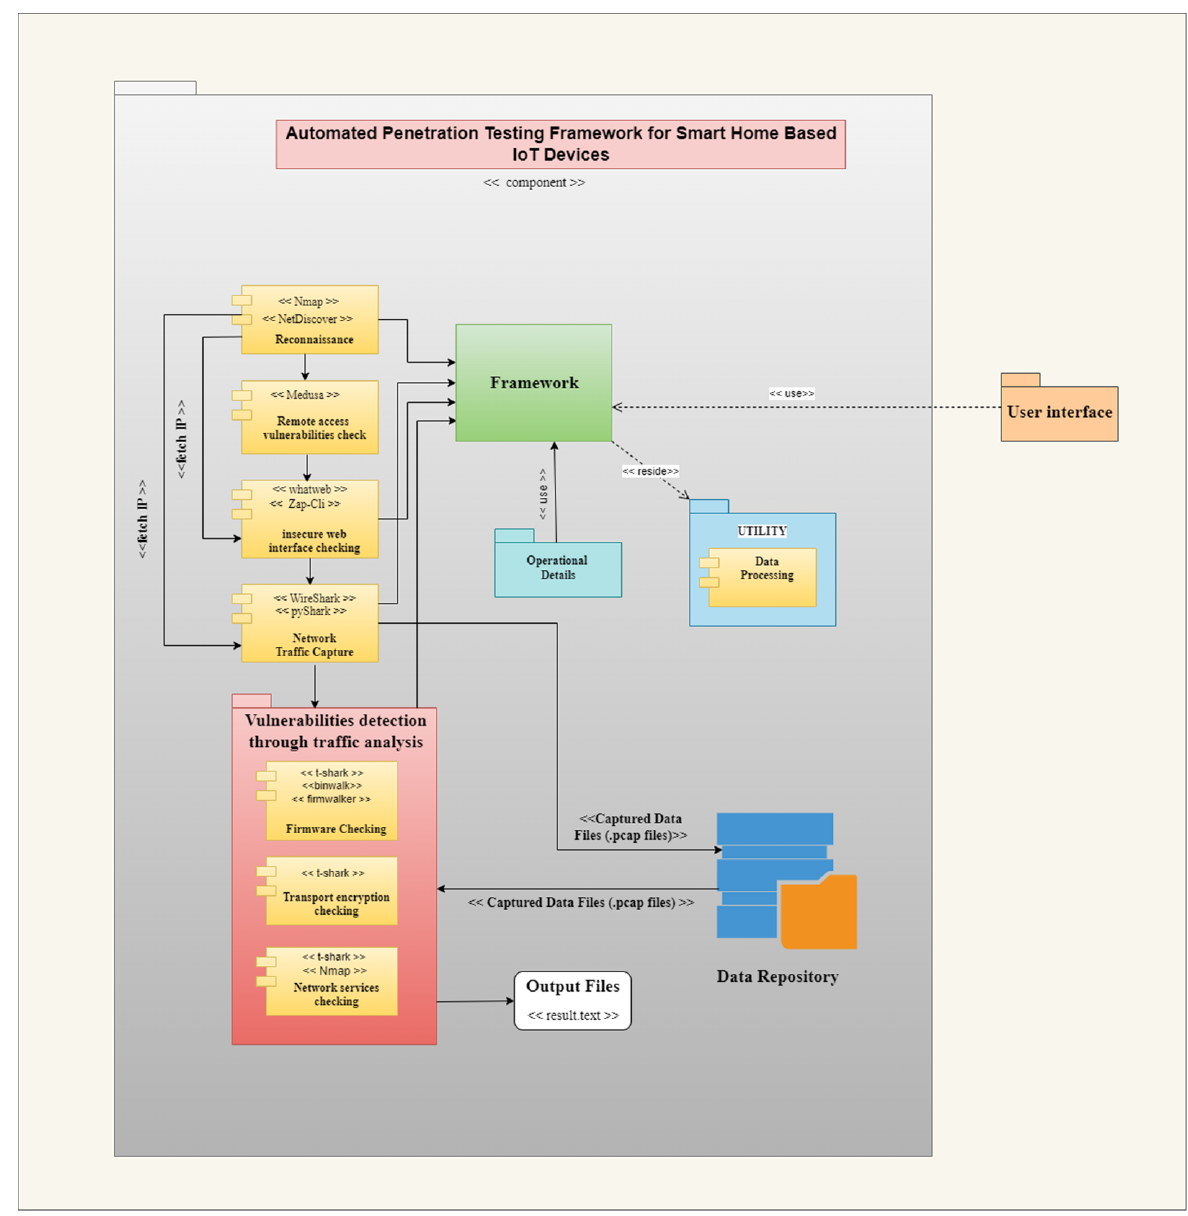
Figure 4. UML component diagram of the framework.